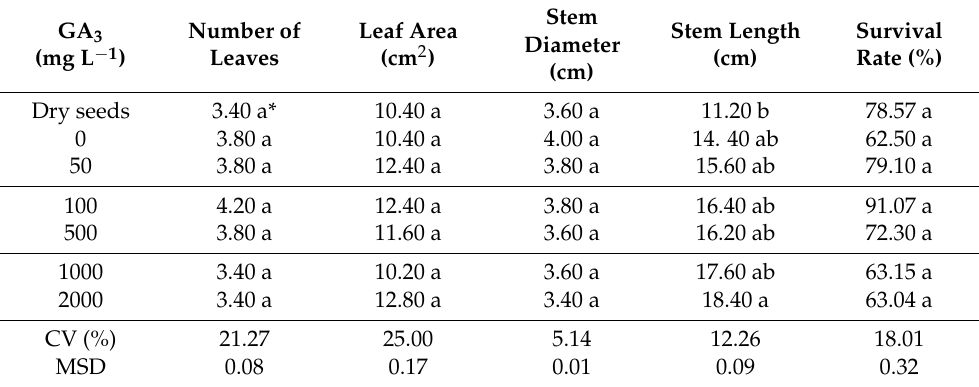
Table 3. Number of leaves, leaf area, stem diameter, stem length, and survival rate of C. brasiliense tree seedlings from seeds stored for 40 days, pre-soaked in concentrations of GA 3 and dry seeds, without pre-soaking, at 30 days after transplanting into plastic